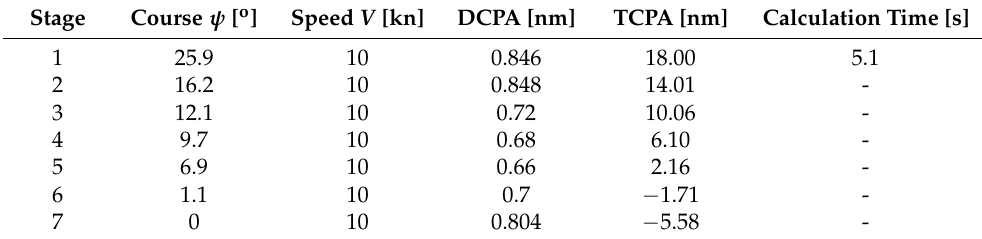
Table 3. Data on the trajectories of the ship — ACEA algorithm.